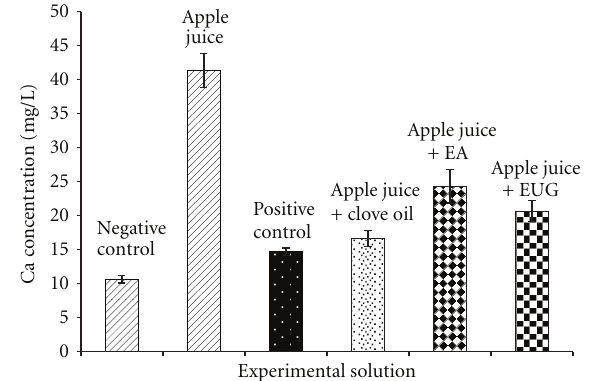
Figure 2: Calcium concentrations (mg/L) was measured for all groups, without apple juice as negative control (dark bar) and fluoride as positive control (white dots bar). Subsequently, test standard-apple juice only obtained after 24 hours incubation with the tooth (crossed bar), apple juice with clove oil incubated with tooth (black dots bar), apple juice with eugenyl acetate (EA) incubated with tooth (diamonds bar), and apple juice with eugenol (EUG) incubated with tooth (square bar). Measures were assessed using ICP-OES. Calcium was expressed as mg/L from the source and for test juice after swishing with and without teeth.